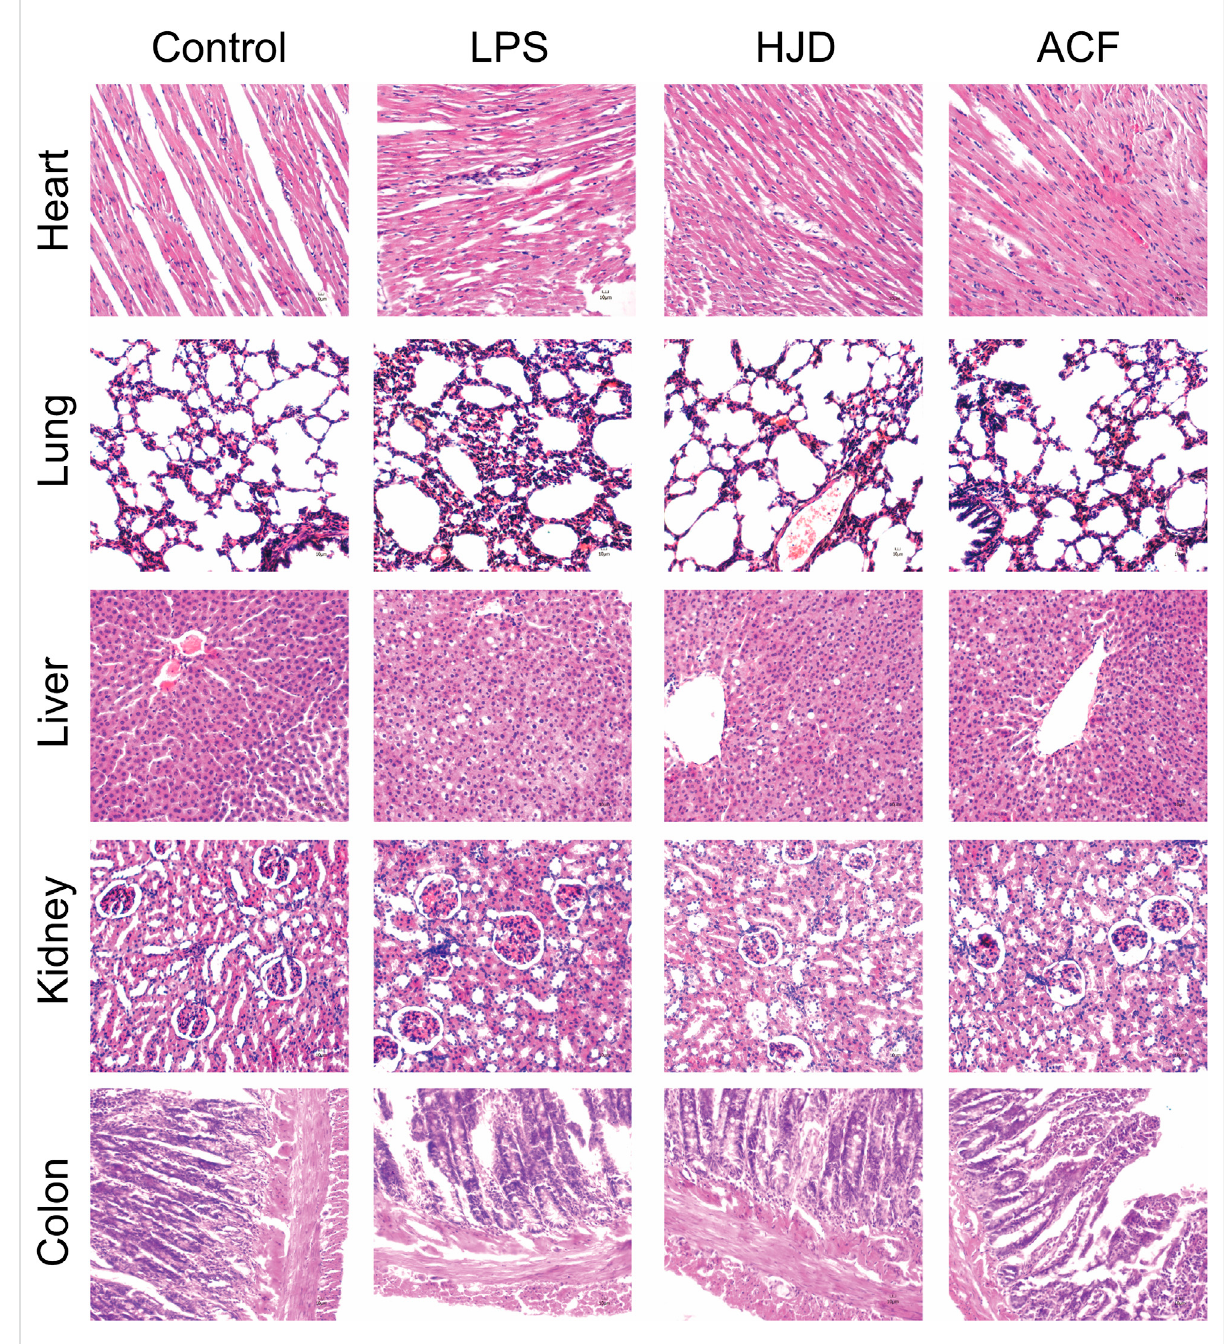
FIGURE 4 Pathologicalchangesoftheheart,liver,lung,kidney,andcolontissuesofratsineachgroupbyhistologicalanalysis(X200).(Pathologicalresults: compared to thenormal group, the heart, lung, liver, kidney, and colon tissues all exhibited alarge number of in fl ammatory cell in fi ltration inthe LPS group. Therefore, for heart tissues, the myocardial cells in the LPS group were disordered in arrangement, and the transverse striations were blurry and broken. The lung injury in the LPS group was alveolar congestion and edema; the liver cells had an irregular and disordered cord-like arrangement and unclear boundaries in LPS group; the glomeruli showed abnormal size and swelling with unclear boundaries in the LPS group; the colonic mucosa disruption, goblet cell loss, and epithelial shedding were observed in the LPS group, and ACF and HJD groups had signi fi cant improvement effects on